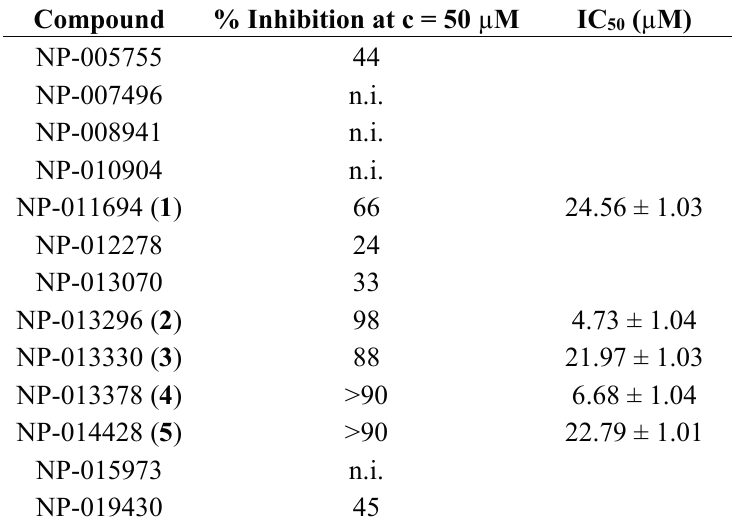
Table 1. Experimental data of the compounds tested in the Tb GAPDH inhibition assay; data represent inhibition values in % at 50 µM (n.i. = no inhibition at 50 µM) and IC 50 values in µM